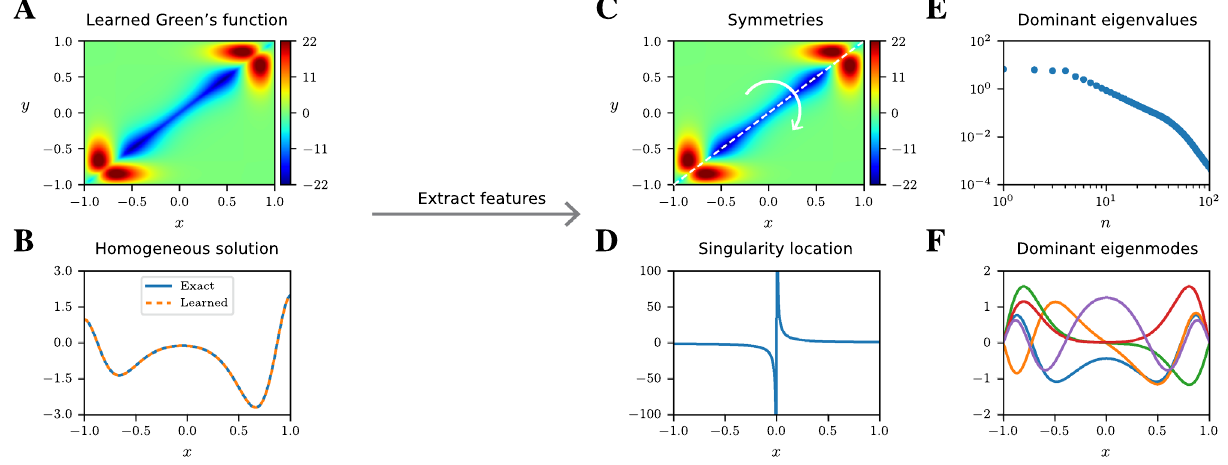
Figure 2. Feature extraction from learned Green’s functions. The NNs for the learned Green’s function ( A ) and homogeneous solution ( B ) enable the extraction of qualitative and quantitative features associated with the differential operator. For example, the symmetries in the Green’s function reveal PDE invariances ( C ), poles of rational NNs identify singularity type and location ( D ), the dominant eigenvalues ( E ) and eigenmodes ( F ) of the learned Green’s function are related to the eigenvalues and eigenmodes of the differential